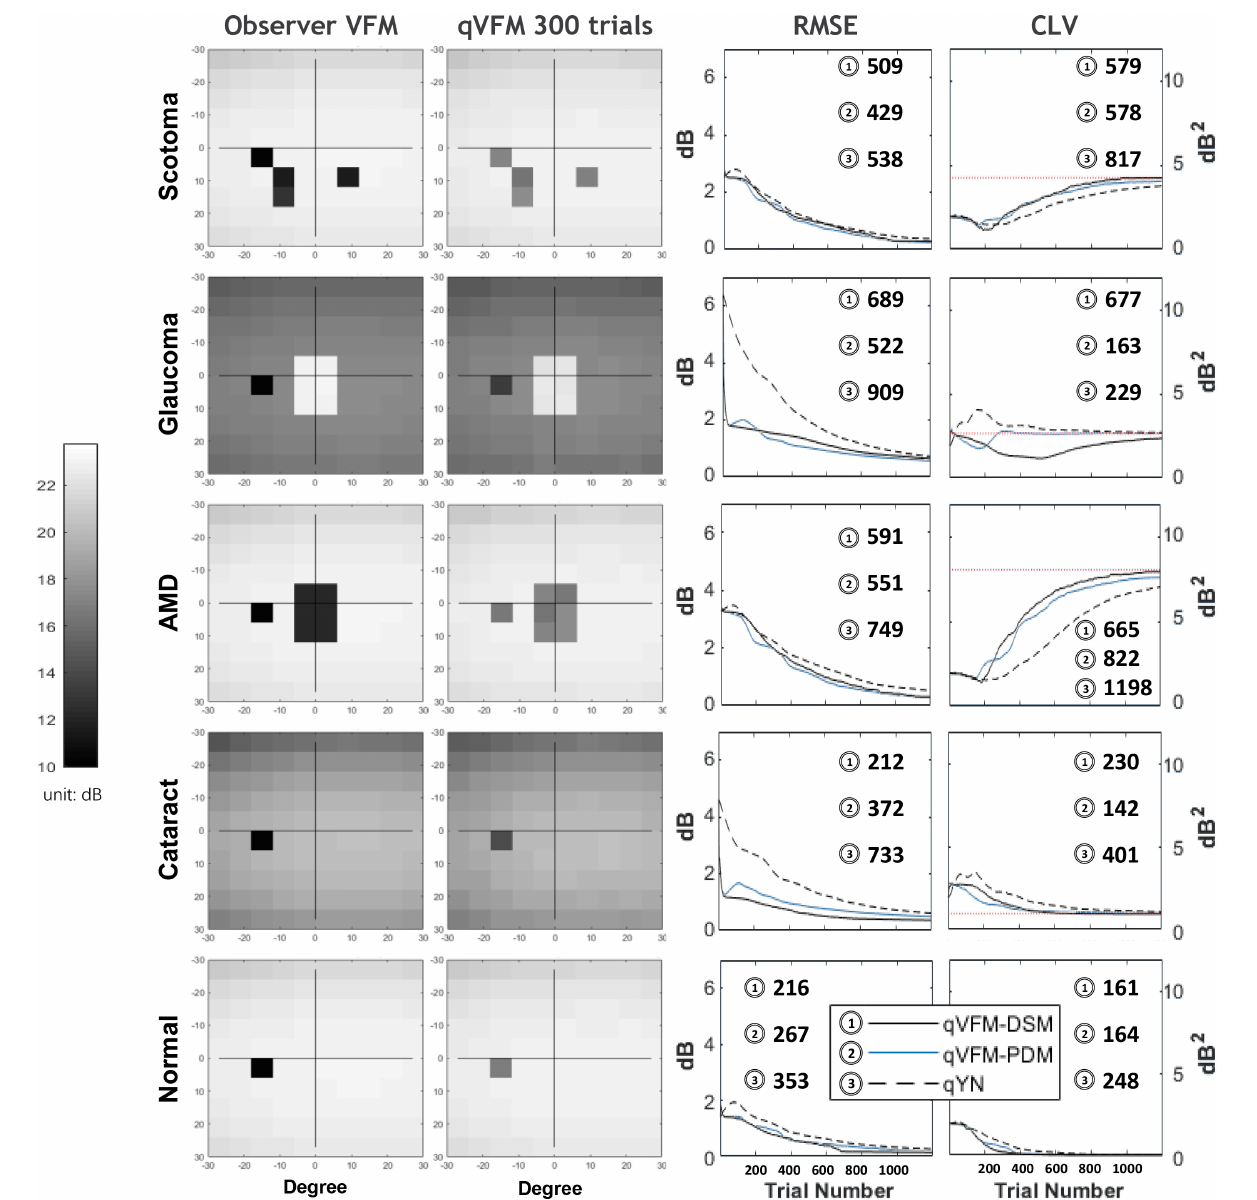
FIGURE 1 | Summary results from the five simulated observers across 200 runs. The true VFM of each simulated observer (monocular) is presented in the first column with an achromatic colormap. The estimated VFMs obtained with the qVFM-PDM method after 300 trials are presented in the second column. The corresponding root mean squared error (RMSE) and corrected loss variance (CLV) of the estimates as functions of trial number are shown in the third and fourth columns. The trial numbers needed to achieve 1 dB RMSE and 1 dB 2 within CLV are shown in the corresponding subplots for the three methods.